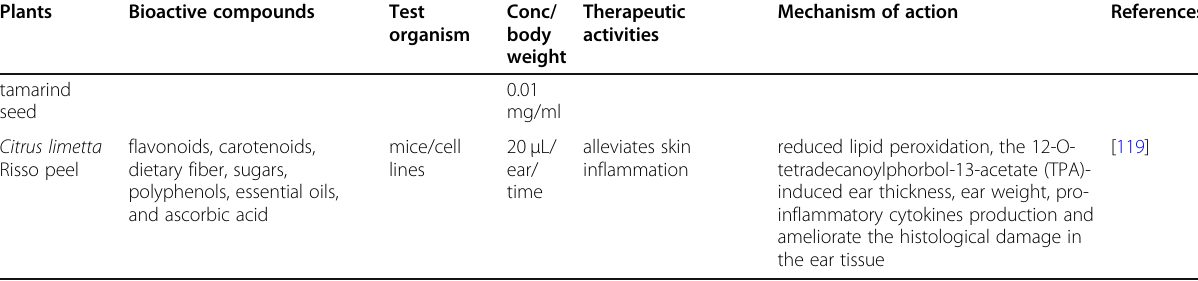
Table 9 other therapeutic properties of some peels and seed extracts (Continued)